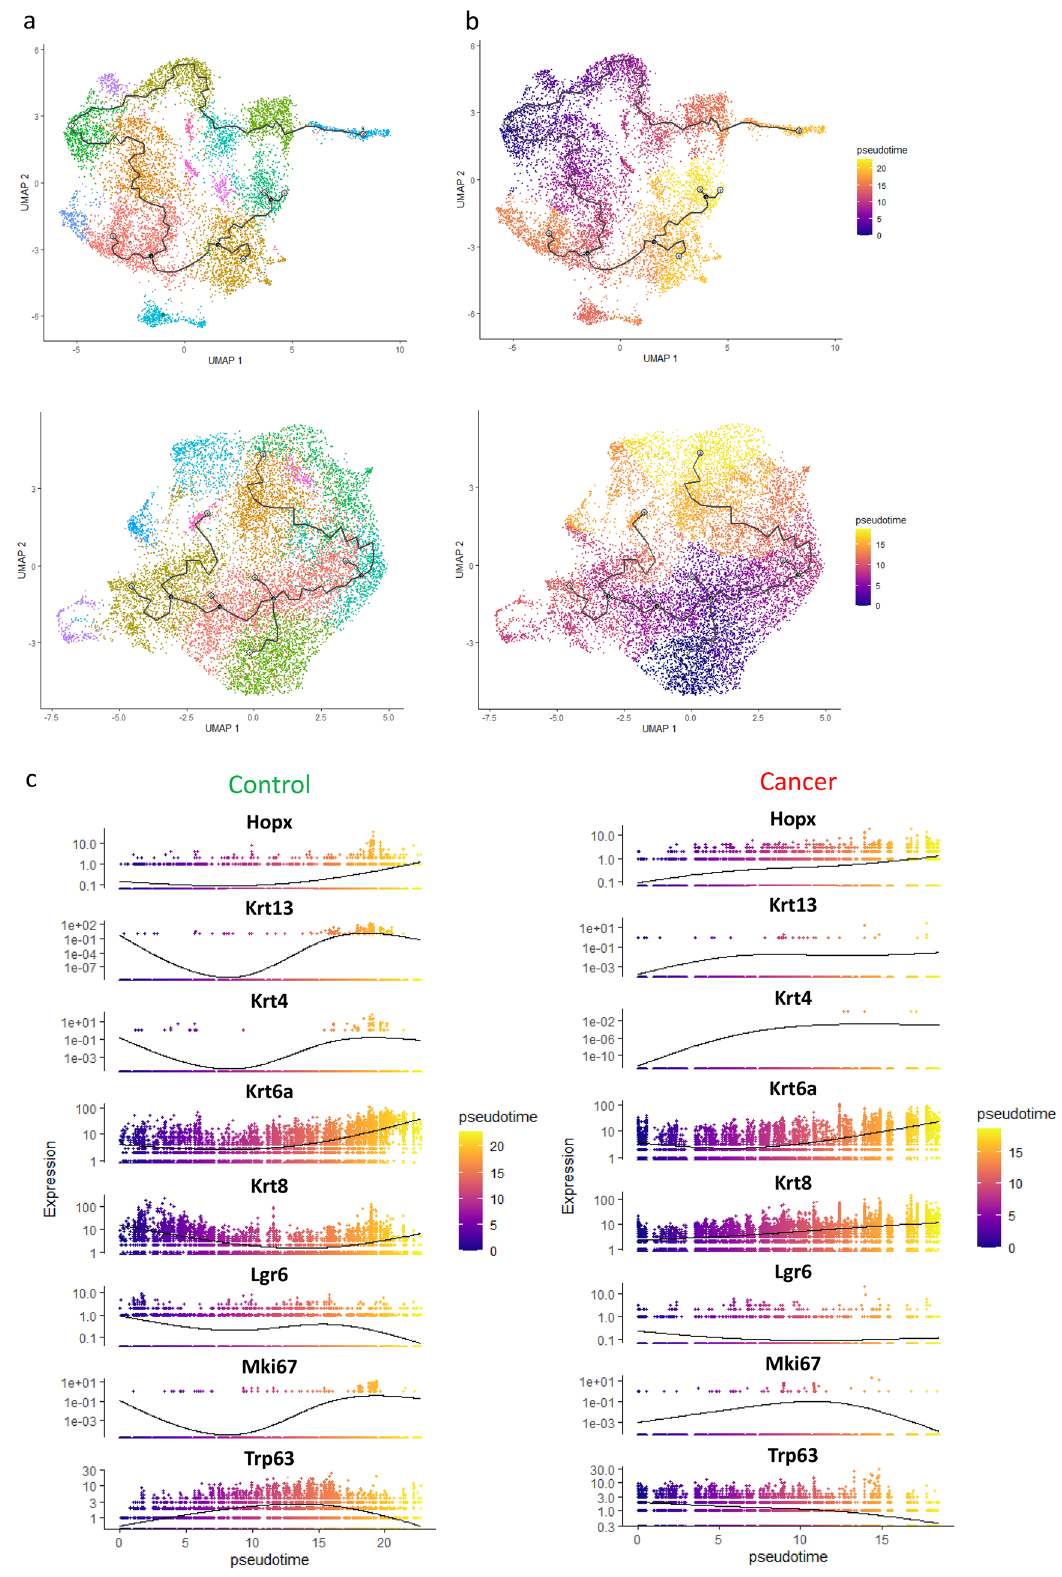
Figure 3. Trajectory analysis of cells from control and cancer organoids. Single-cell trajectories for control (upper) and cancer (lower) organoid datasets predicted by Monocle3 and visualized by uniform manifold approximation and projection (UMAP) plots colored by ( a ) Seurat clusters and ( b ) pseudotime, in a differentiation gradient from purple to yellow using the clusters with high StemID scores as root nodes. ( c ) Selected markers for progenitor, stem, and differentiated cells plotted in pseudotime for the control (left) and cancer (right)